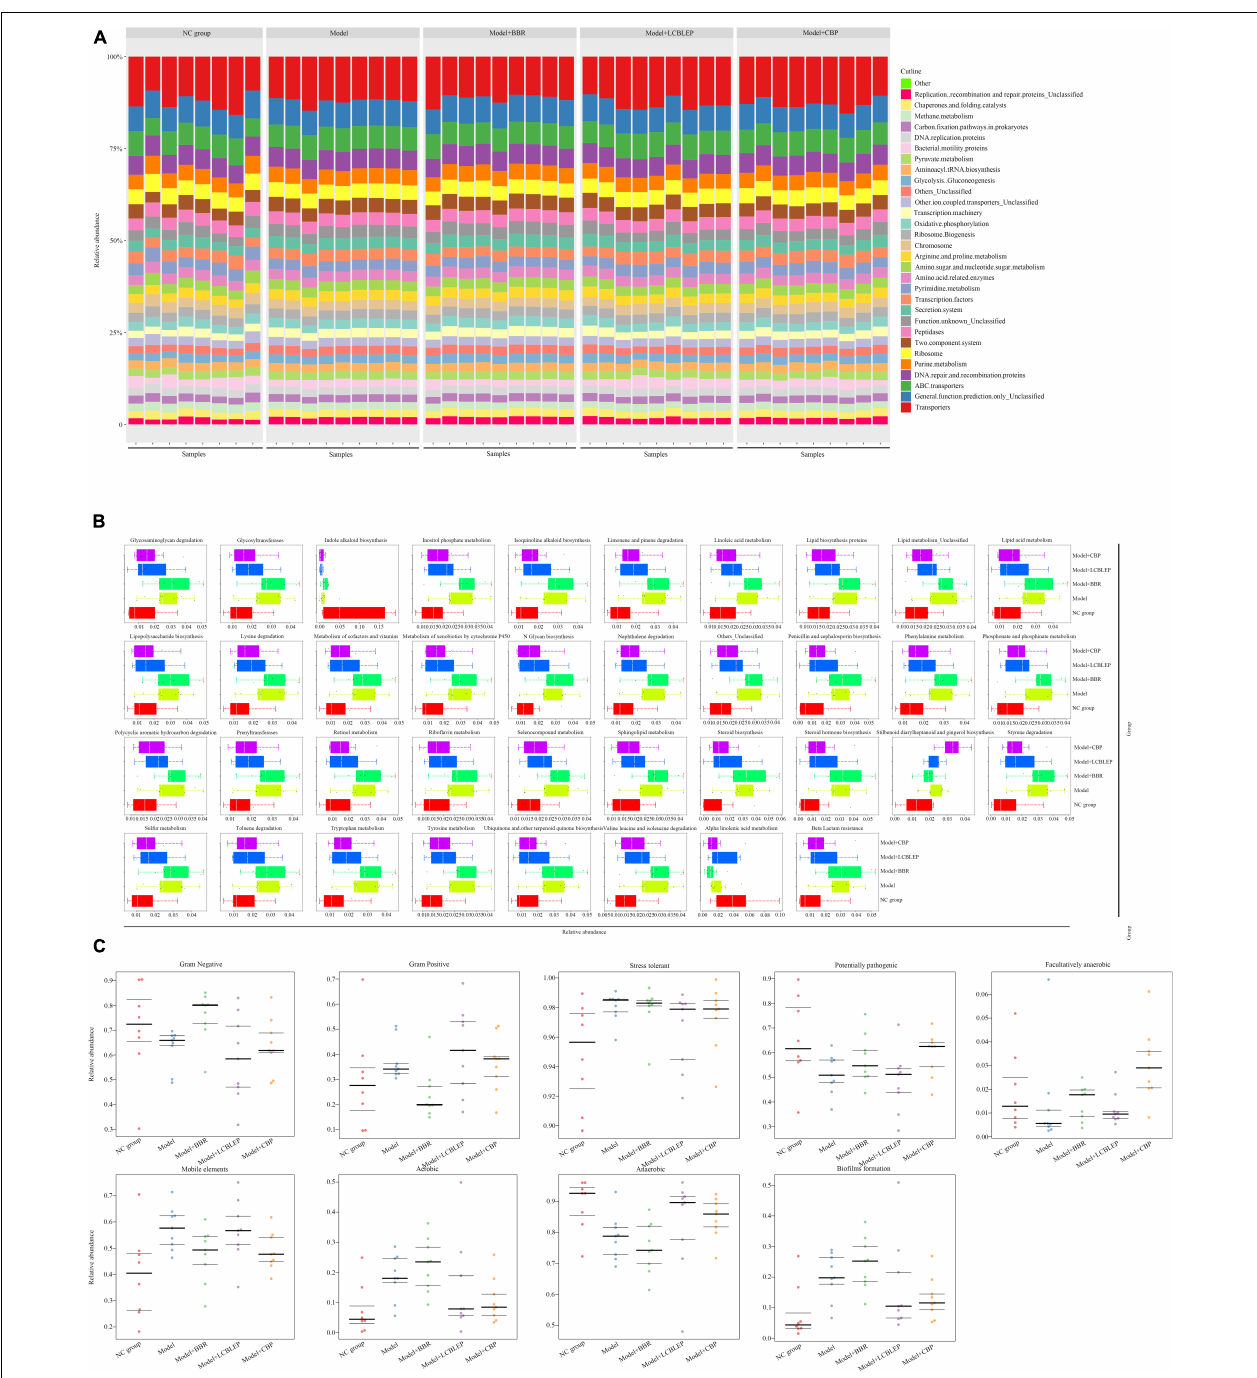
FIGURE 5 | (A) Prediction of microbial metabolic function was performed through PICRUSt based on 16S rDNA sequence, and the enrichment of functional genes in KEGG Pathways with levels 3 was obtained, with a histogram of the top 30 metabolic pathways with the highest abundance. (B) Box diagram for function prediction of KEGG level3 of differences between groups in genus level. (C) Comparison of phenotypic classification for microbial metabolic function based on BugBase, and the three lines represented the upper, the mean, and the lower quartiles from top to